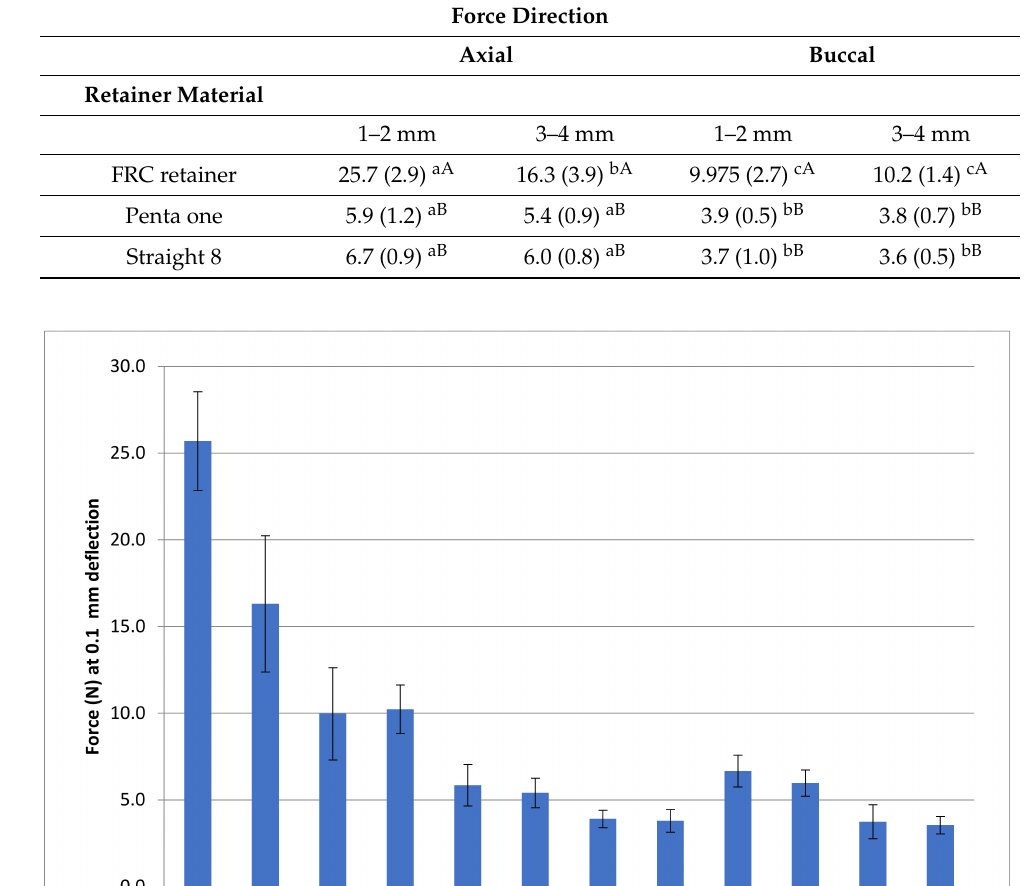
Table 3. Load values (in N) required to cause 0.1 mm movement of tooth d.31 with retainers of different materials, positioned from two distances from the incisal edge (1–2 mm; 3–4 mm) and